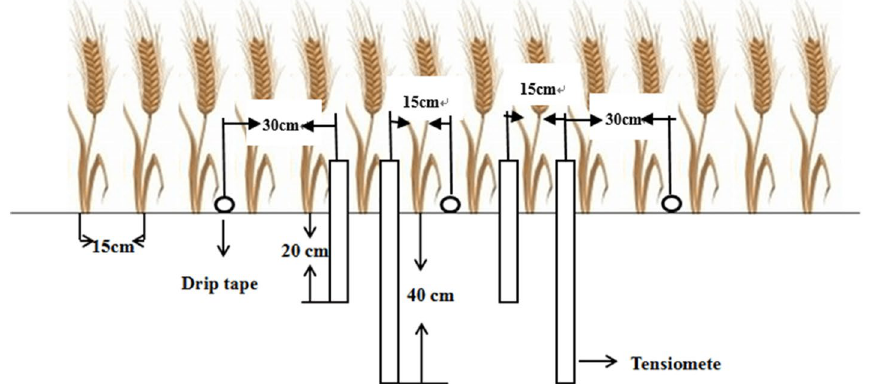
Figure 1. Sketch map showing the relative positions of the drip laterals, the wheat rows, and the Watermark Root weight density (RWD) and root length density (RLD). Root morphology was assessed at flow- ering during 2013 and 2014 using the core sampling method 21 . Three hills were collected from the 0–40 cm depth of each split plot using a soil corer (5 cm diam). The samples were divided into 0–20 and 20–40 cm depths and then washed with tap water on a 0.5 mm mesh screen. Grass roots and other organic debris were removed from the samples. The roots were then digitally analyzed using a flatbed image scanner (Epson V500; Epson America, Inc., San Jose, CA, USA) as described by Kato et al. 22 . The root lengths were determined with Win- RHIZO commercial software (Regent Instruments, Montreal, QC, Canada). After scanning, the samples were dried in an oven at 75 °C for 72 h and then weighed. Using data from the above measurements, we calculated root length density (RLD, root length per volume of soil, cm/cm 3 ), root weight density (RWD, root weight per volume of soil, g/m 3 ) and specific root length (the ratio of root length to root weight, m/g). Leaf area index at flowering (LAImax), dry matter, and grain yield. The aboveground plant sam- ples were collected along with roots at flowering. The samples were separated into leaves, stems, and panicles. The green leaf area was measured with an LI-3100 leaf area meter (LI-COR Inc., Lincoln, NE, USA). The samples were dried in an oven at 75 °C for at least 72 h and then weighed. Specific leaf area (SLA) was calculated by divid- ing leaf weight by leaf area 23 . The root:shoot ratio (dry weight basis) and the root dry weight per unit leaf area (RDMPLA) were also calculated. Grain yield was determined from a 1 m 2 area in each split plot and adjusted to a moisture content of 0.14 g H 2 O/g fresh weight. Panicle dry weight and yield components were determined using three subsamples from three 1 m 2 areas in each split plot. Net photosynthetic rate (Pn).